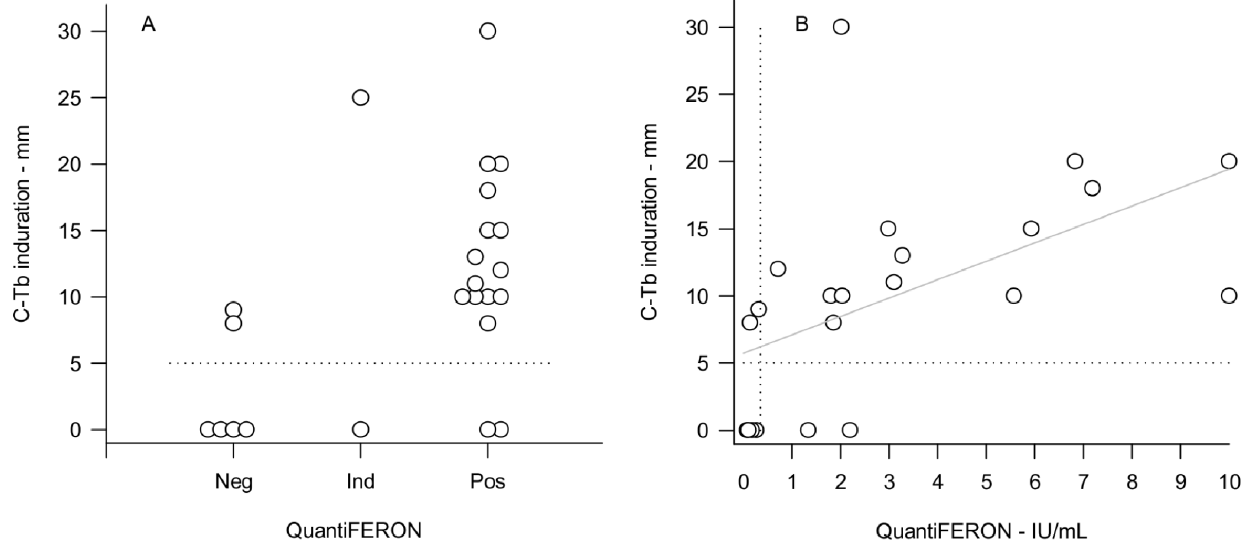
Figure 5. QFT-IT and C-Tb responses in patients with active TB. QFT-IT positive-negative result (panel A) and baseline concentration of IFN c (panel B) at screening versus induration diameter 3 days after injection of 0.1 m g preserved C-Tb to TB patients (N=24). Indeterminate (Ind) results are omitted in panel B. Dotted lines represents cut-off values. Regression line is shown in panel B.